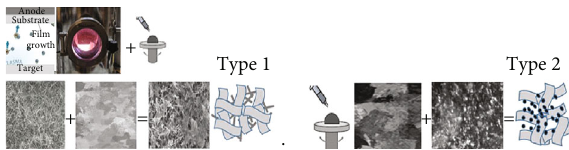
Figure 2: Process fl ow for two types of heteronanostructure